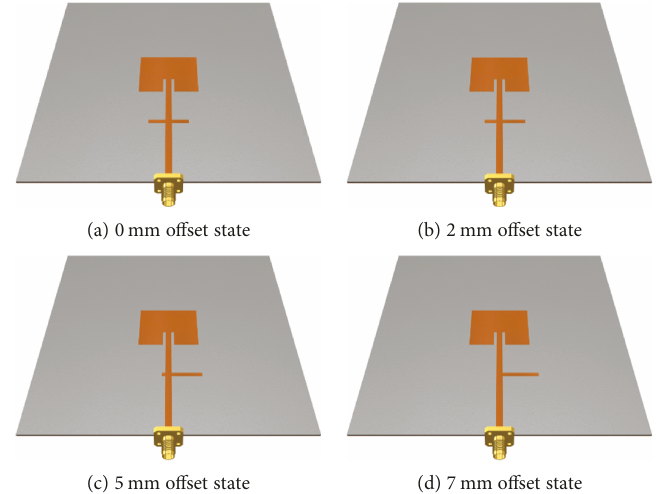
Figure 1: Copper-baseline gain-recon fi gurable antenna states: (a) 0mm o ff set state: the midpoint of the copper stub coincides with the center of the 50 Ω copper microstrip feed line; (b) – (d) X -mm-o ff set state: the midpoint of the copper stub is X mm from the center of the microstrip feed line. Note that the copper stub is 15 × 1.5 × 0.1mm 3 .